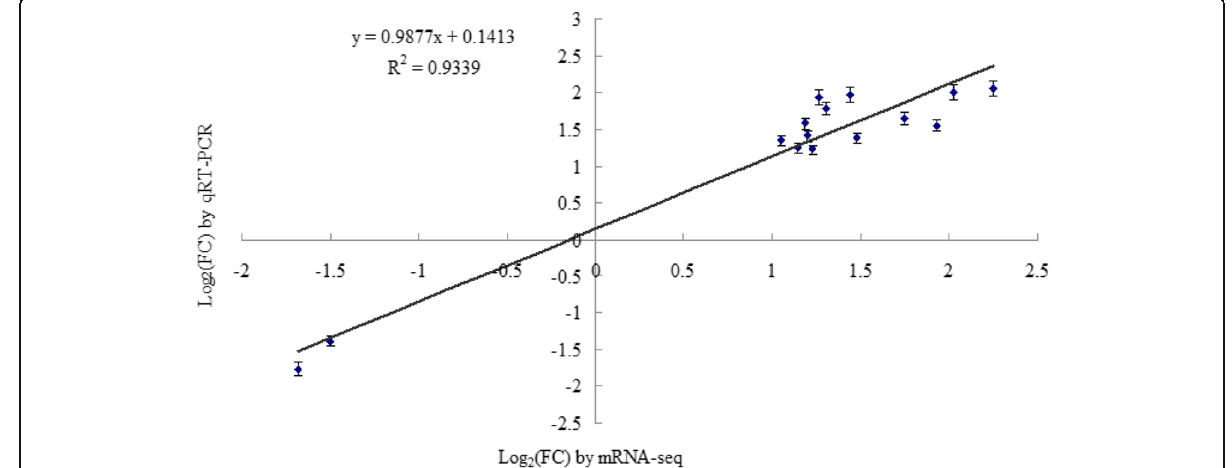
Fig. 3 Comparison of the log2 (FC) of 15 randomly selected transcripts using RNA-Seq and qRT-PCR